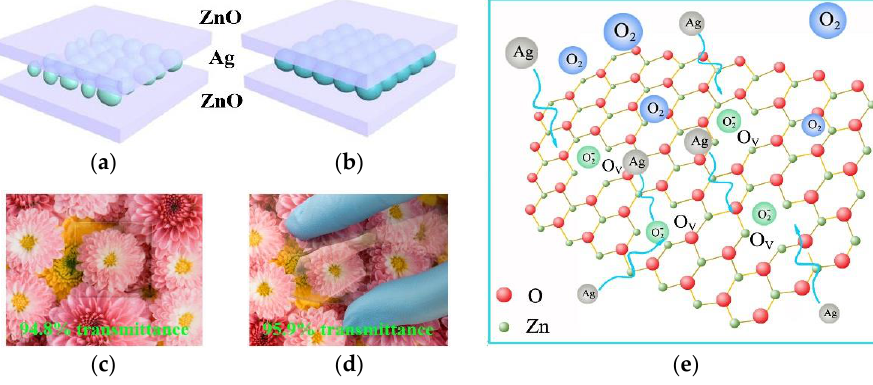
Figure 1. Schematic pictures of ZnO/Ag/ZnO films: ( a ) without O 2 ; and ( b ) with O 2 . Optical images of ZnO/Ag/ZnO with O 2 on: ( c ) rigid glass substrate; and ( d ) flexible PET substrate. ( e ) Schematic diagram of the oxidation-induced effect. Figure 2 indicates the X-ray diffraction (XRD) patterns that verify the phase of ZnO/Ag/ZnO films. The peaks at 33° was assigned to the (002) plane of ZnO (JCPDS No. 36-1451) and the obvious